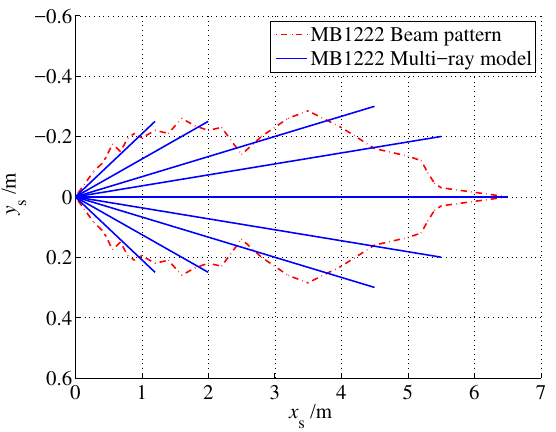
Figure 6. The multi-ray model of the MaxSonar MB1222 sonar sensor.